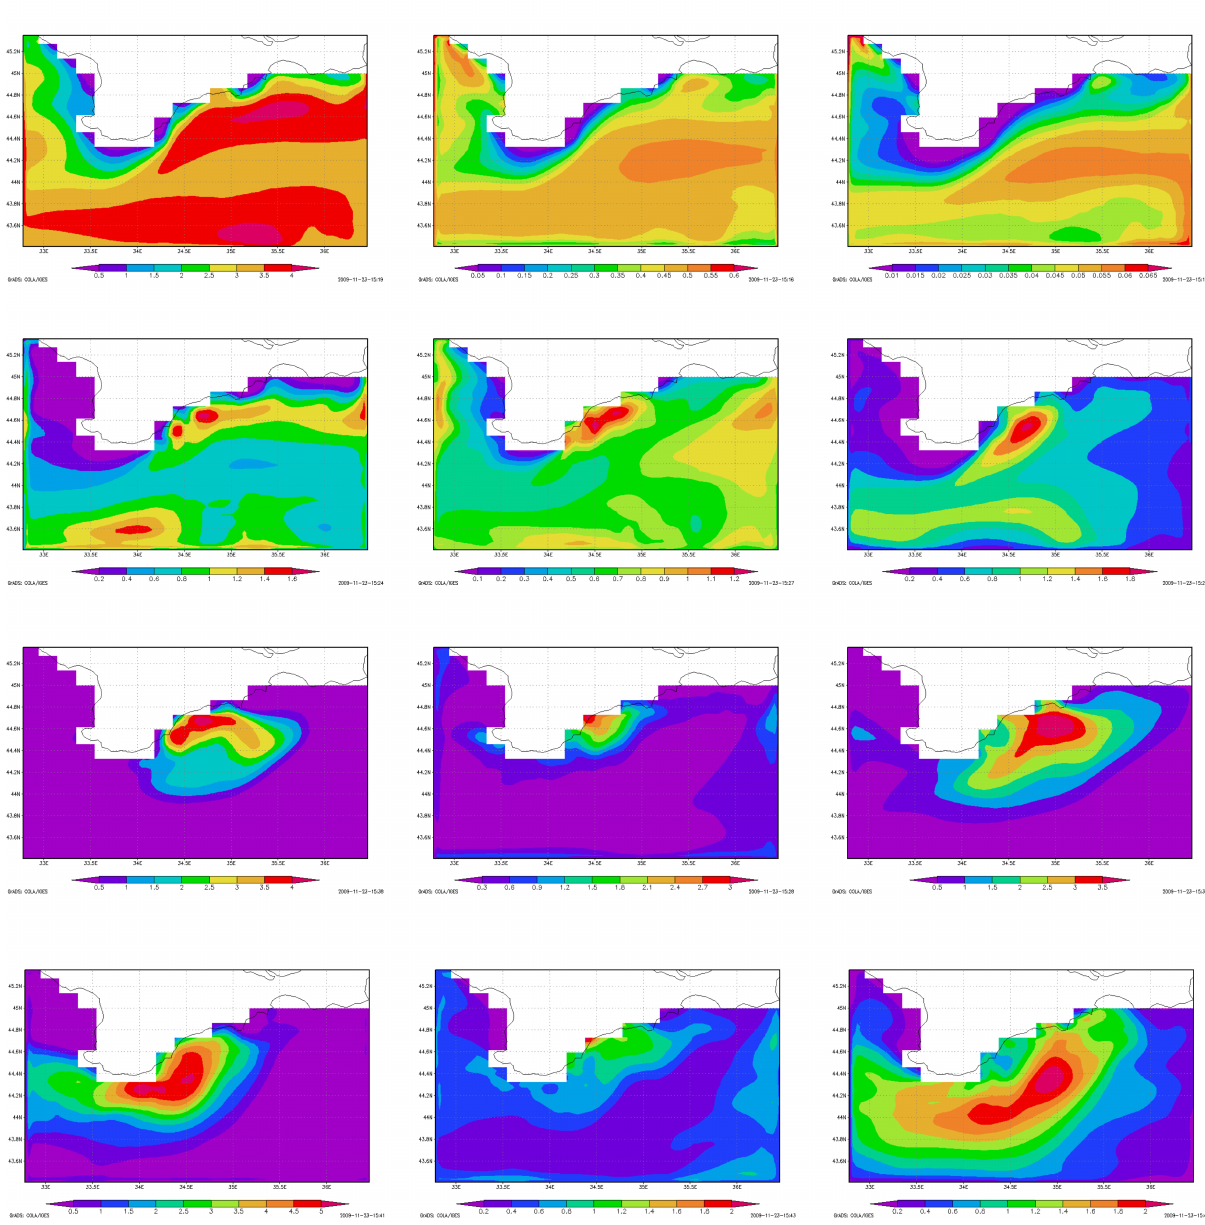
Fig. 3. Season-mean distribution (upper row – winter, then spring, summer and autumn) of surface nitrate (left), phytoplankton (central) and zooplankton